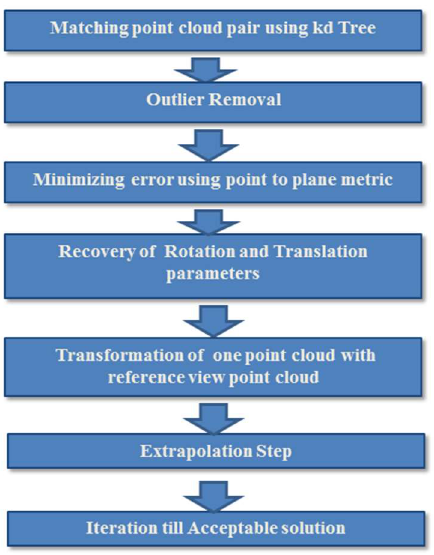
Figure 3. Block diagram of the ICP algorithm depicting different steps for point cloud refinement.